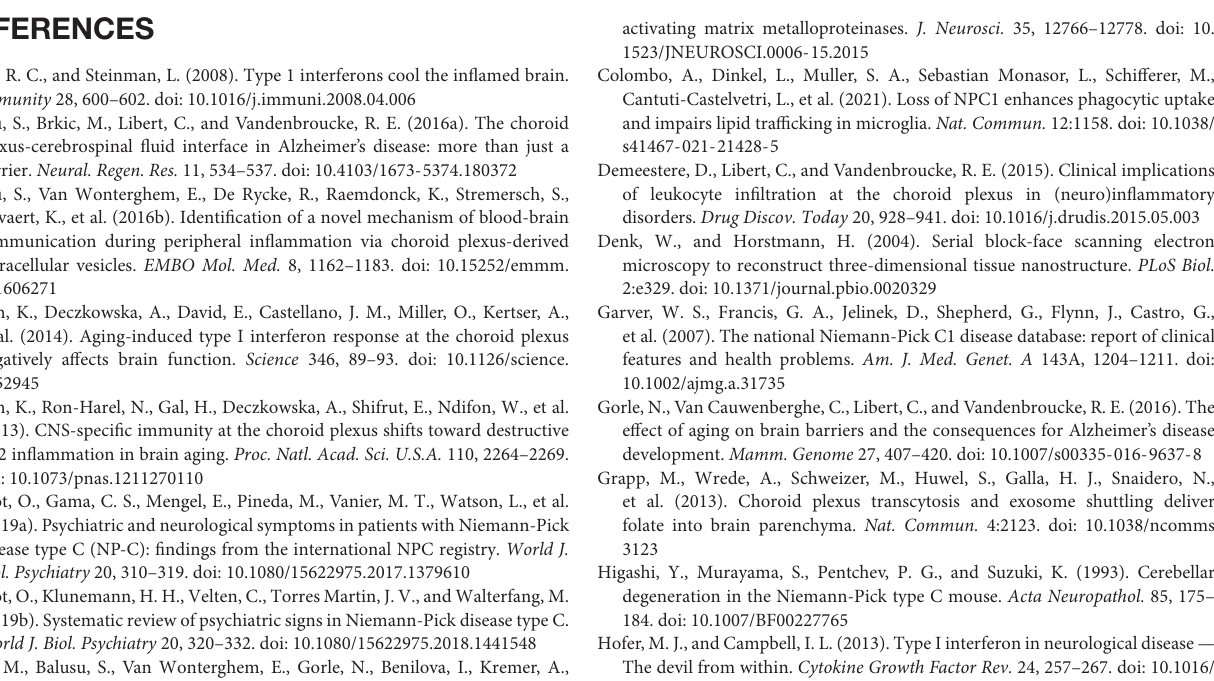
Supplementary Figure 1 | Increased expression of type I IFN response genes in the choroid plexus of NPC1 − / − mice compared to NPC1 + / + littermates. qRT-PCR analysis of choroid plexus isolated from NPC1 + / + ( n = 6; black) and NPC1 − / − ( n = 6; white) of 7 weeks old mice. Results are represented relative to the NPC1 + / + condition. Data are shown as mean ± SEM. Statistical analyses on datasets were performed by Mann–Whitney test. Asterisks indicate statistical significance ( ∗ p < 0.05, ∗∗ p < 0.01). Supplementary Figure 2 | Representative images of TUNEL staining (red) of the corpus striatum and prefrontal cortex of wild type mice injected with EVs isolated of choroid plexus explants of NPC1 + / + and NPC1 − / − . Cell nuclei are counterstained with Hoechst (blue) ( n = 4–5). Scale bar represents 200 µ